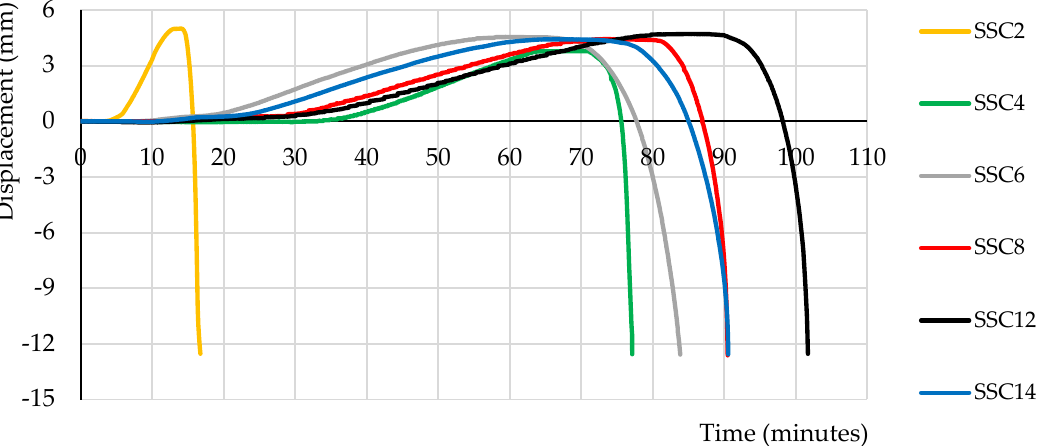
Figure 12. Evolution of vertical deformation in the specimens of SSC as a function of time.